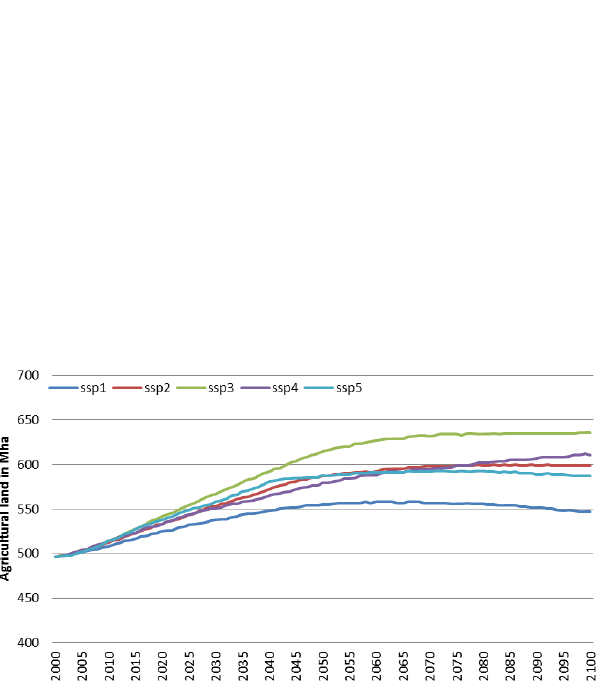
Figure B6. Expansion of total agricultural land, including grass- land and cropland, in the Sahel for the socio-economic